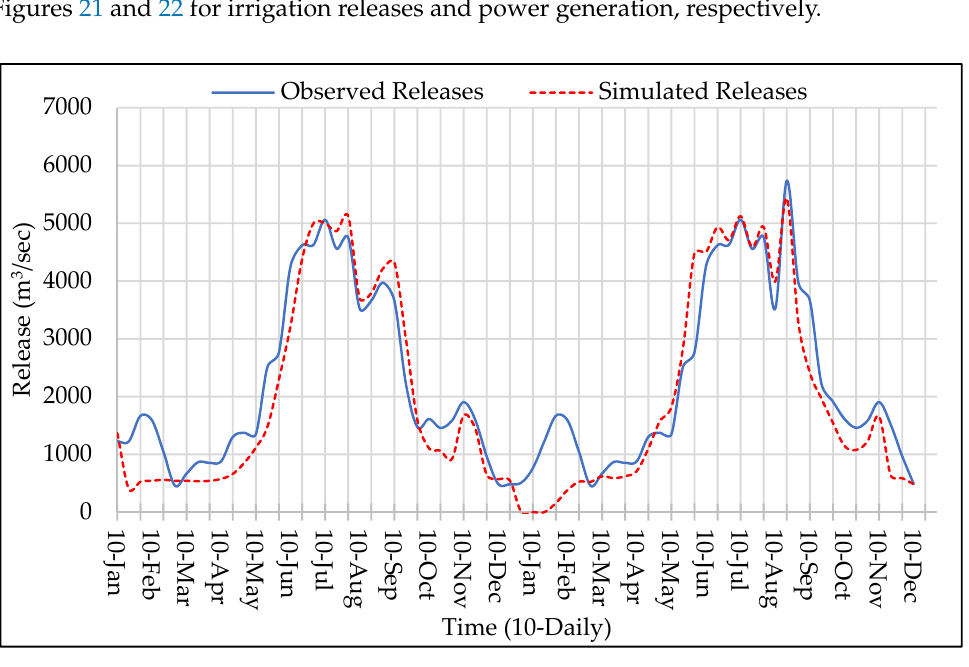
Figure 21. Calibration of the Model for Irrigation Releases (2012 and 2013). The coefficient of efficiency, index of agreement and run-off ratio indicate the satisfac- tory values for accuracy of the model as shown in Table 6. Table 6. Model efficiency parameters for Model Calibration year 2012 and